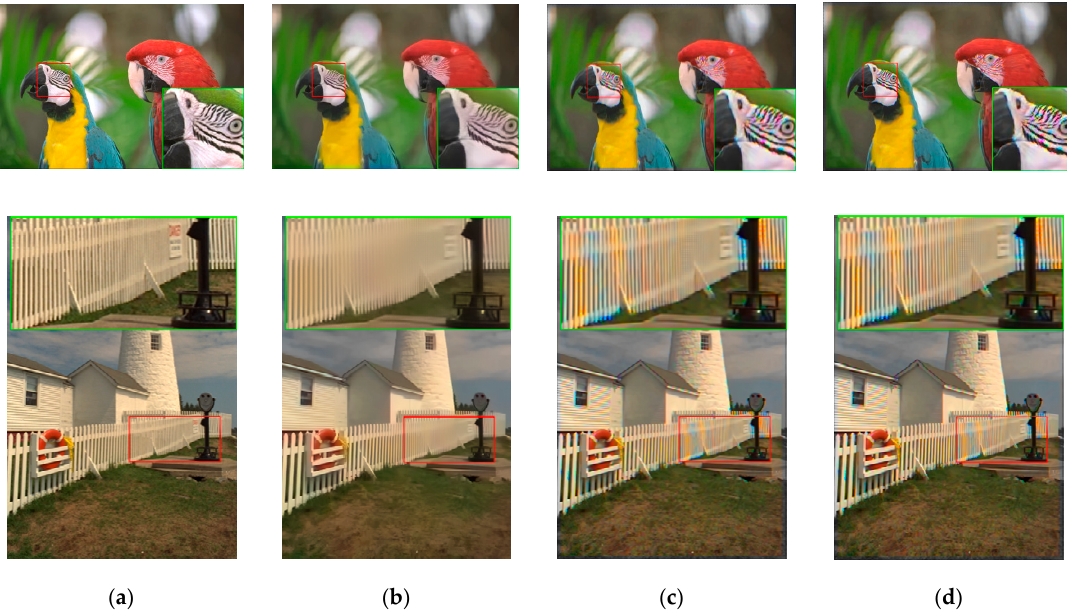
Figure 18. Averaged performance metrics for all the low light images at 20 dBs SNR (Poisson noise). ( a ) PNSR; ( b ) CIELAB; ( c ) SSIM; ( d ) HVS and HVSm.